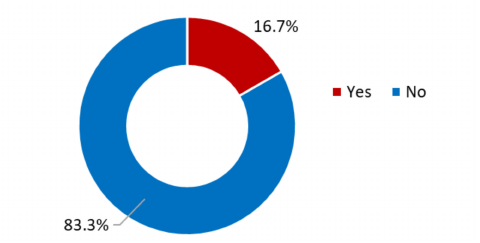
Figure 16. Participants’ involvement in renovation/refurbishment